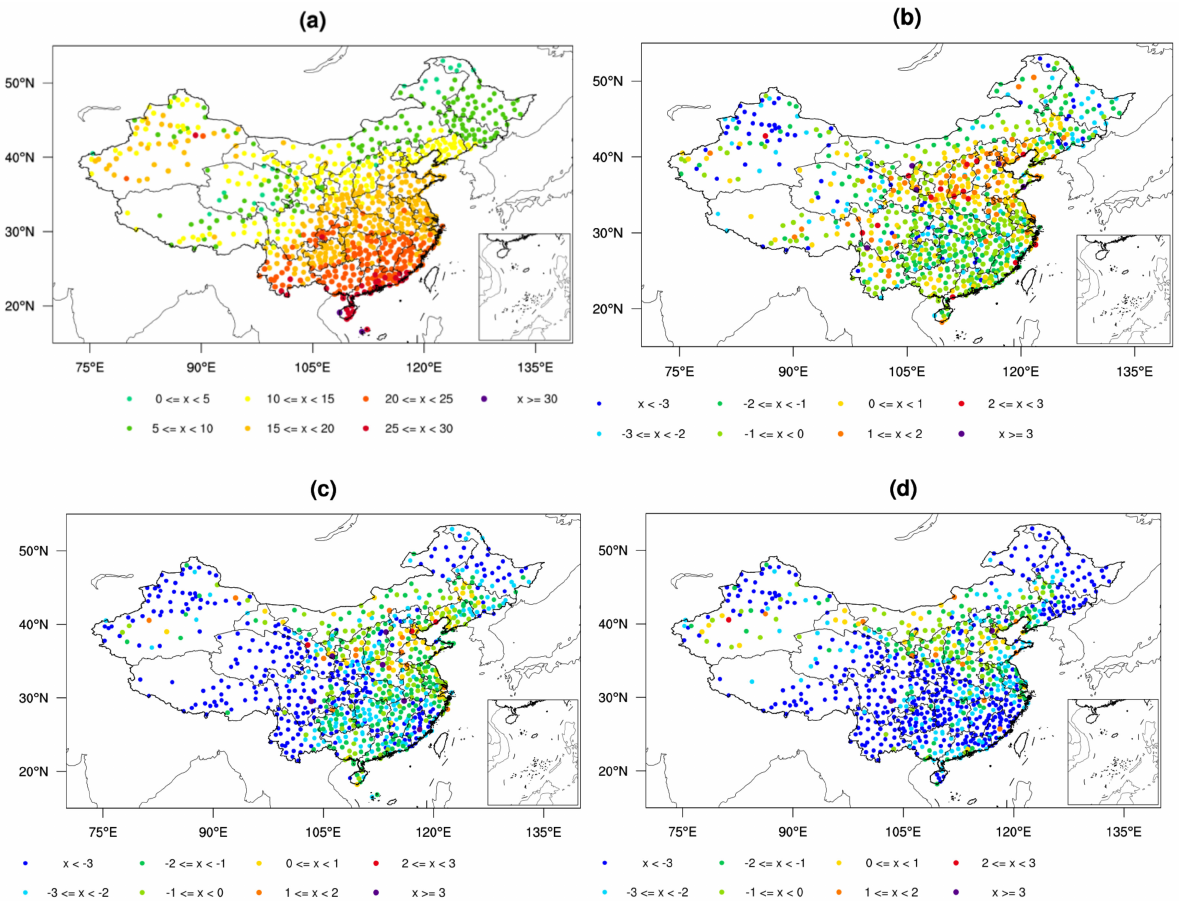
Figure 2. Spatial distributions of the annual averaged ST10 observation ( a ), ST10 ME of CLDAS ( b ), ERA-Interim ( c ), and GLDAS ( d